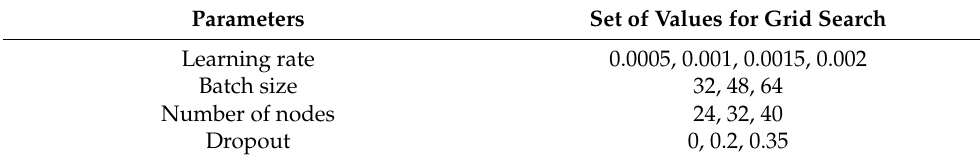
Table 8. Grid search values for exhaustive parameters optimization.